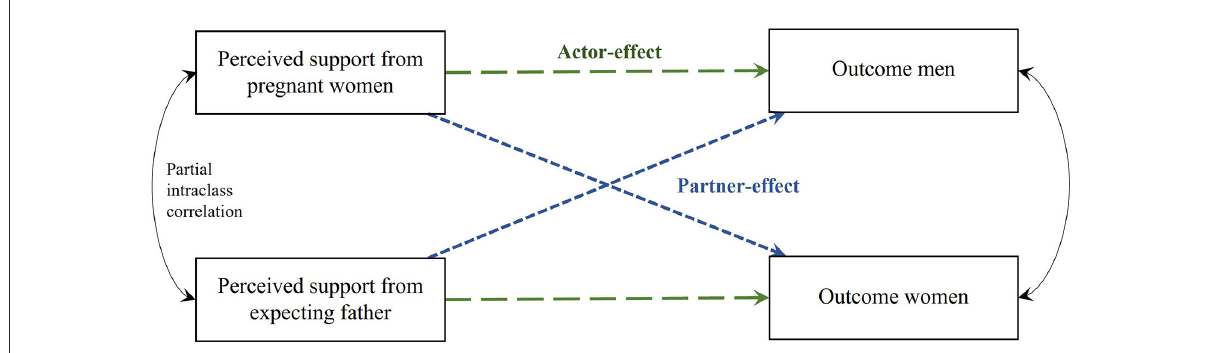
FIGURE2 Actor-Partner Interdependence Model of the relation between perceived partner support and outcome. Green dashed line, actor-effect; blue dotted line, partner-effect.